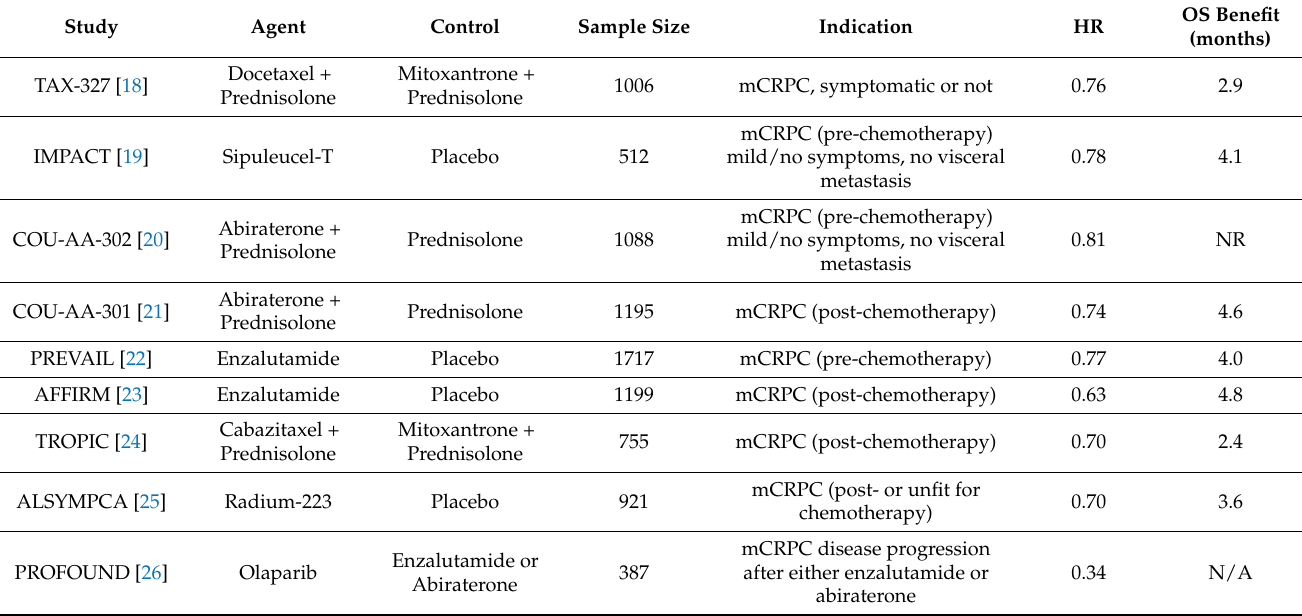
Table 2. Summary of established metastatic castration-resistant prostate cancer (mCRPC) treatment options.